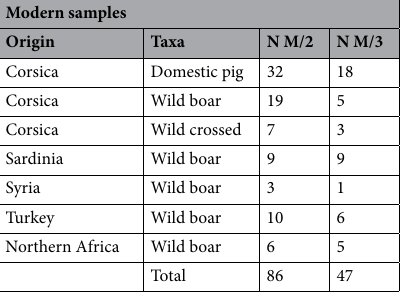
Table 1. Modern samples of wild and domestic Sus scrofa used for dental Geometric morphometrics.